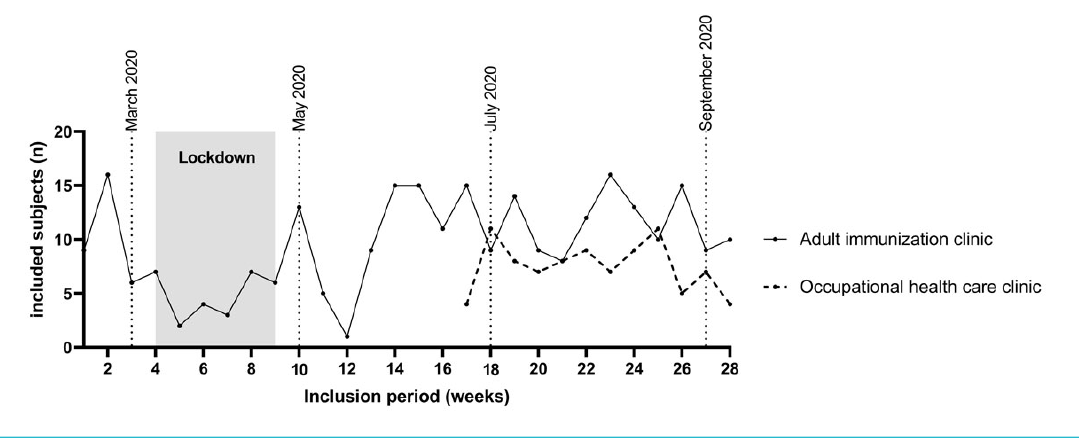
Figure S3: Number of subjects included per week in relation to the lockdown due to the COVID-19 pandemic. Lockdown: due to the COVID-19 pandemic from 16 March until 27 April 2020 all non-emergency medical services were deferred in Switzerland. The few visits at the